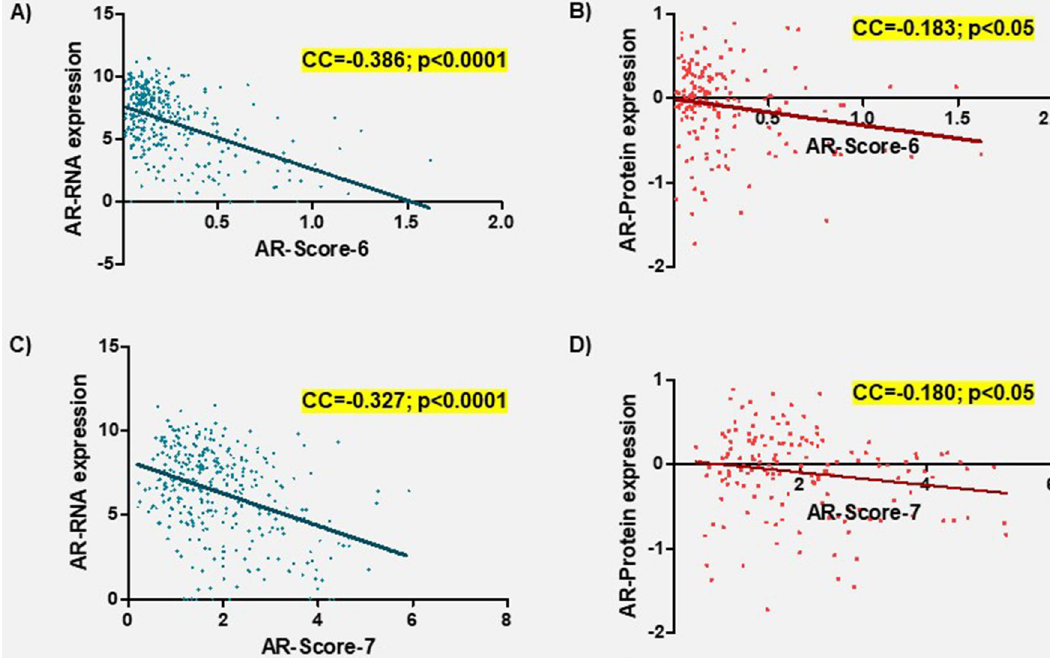
and p-values. All variables have been transformed using log2. CC correlation